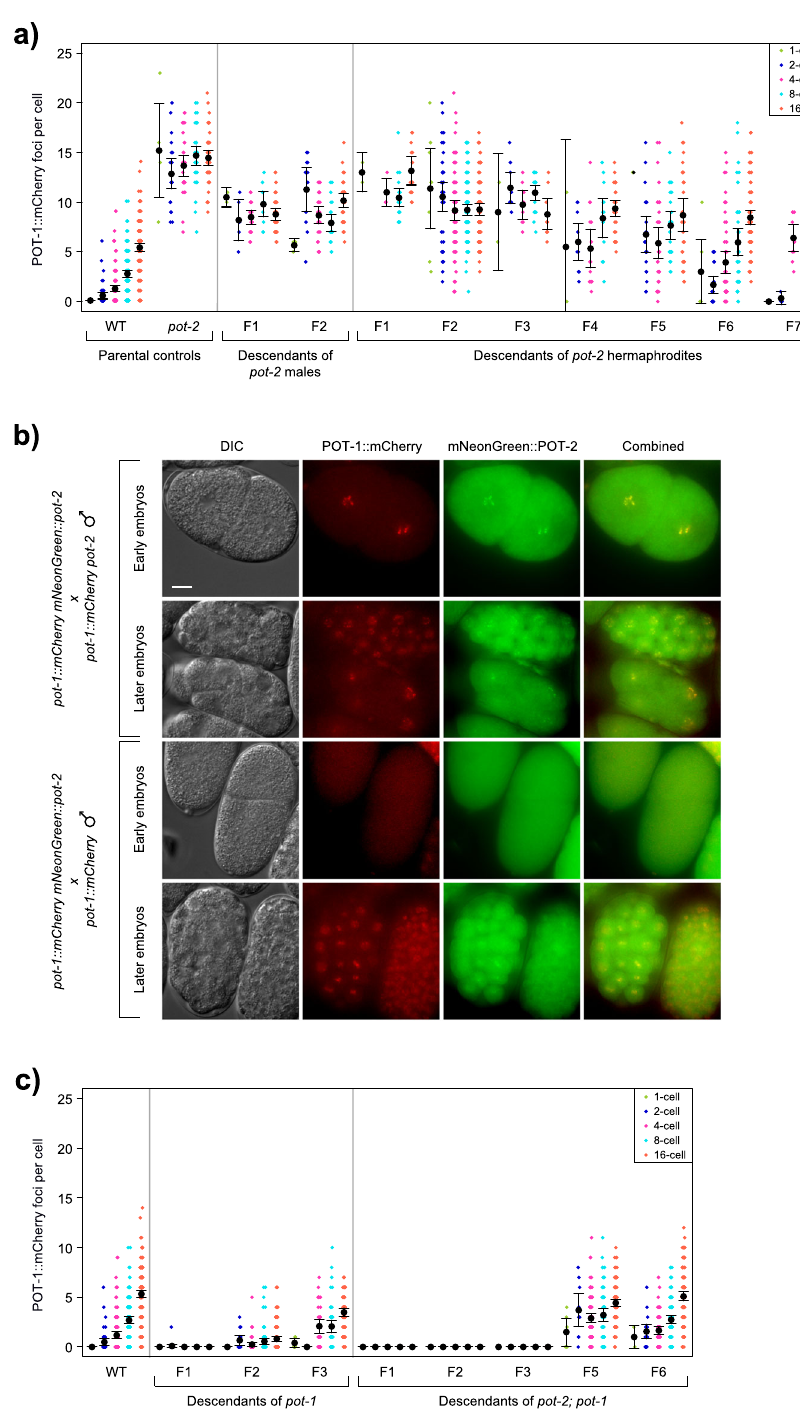
Fig. 2 Pot gene mutations affect Pot1 foci in subsequent generations. a POT-1::mCherry foci per cell in embryos from P0 parental controls and descendants of either pot-2 mutant males or hermaphrodites crossed to POT-1::mCherry worms. Dot color indicates stage of embryo. b F1 early- and late- stage embryos from crosses between pot-1::mCherry mNeonGreen::pot-2 hermaphrodites and either pot-1::mCherry pot-2 males or pot-1::mCherry males. Scale bar is 10 µ m. c POT-1::mCherry foci counts per nucleus in embryos from parental controls and descendants of either pot-1 or pot-2; pot-1 mutant males crossed to POT-1::mCherry worms. Error bars are 95% con fi dence intervals.